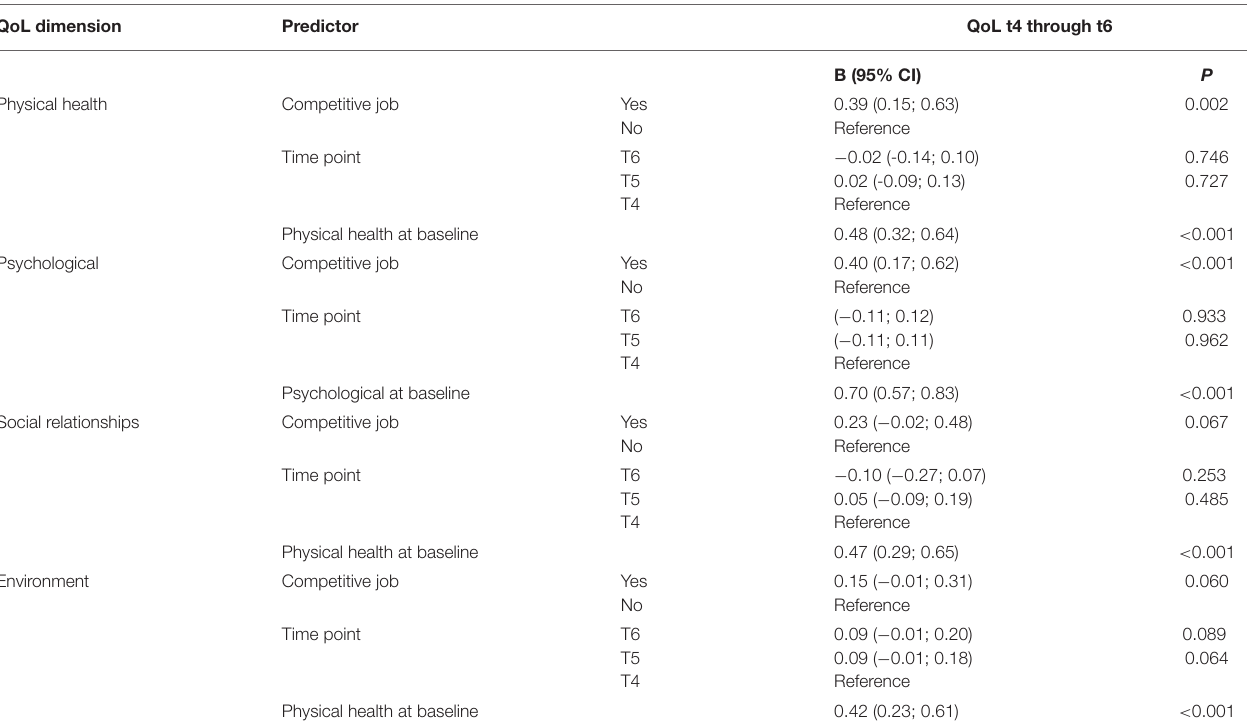
TABLE 3 | Prospective effect of obtaining a competitive job on subsequent QoL, controlling for temporal stability and baseline